Question: Write the caption for this figure.
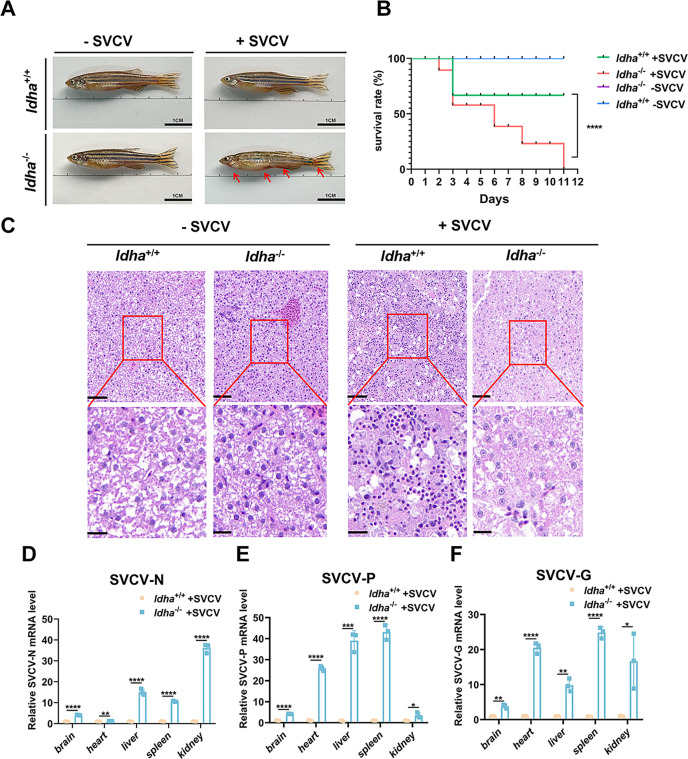
Answer: ldha -null adult zebrafish are susceptible to SVCV infection. ( A ) The ldha −/− zebrafish (3 mpf) displayed enhanced abdominal hemorrhaging compared to the WT controls following the i.p. injection of 10 μL SVCV (~2.5 × 10⁷ TCID₅₀/mL) versus the cell culture medium. The hemorrhagic regions are indicated by red arrows. ( B ) Survival curves for SVCV-infected ldha −/− zebrafish ( n = 20) and their wild-type siblings ( n = 20). ( C ) Hepatic histopathology revealed greater necrosis and cytoplasmic vacuolization in SVCV-infected ldha −/− zebrafish than in their WT siblings. ( D–F ) qRT-PCR analysis of N ( D ), P ( E ), and G ( F ) protein mRNA of SVCV in ldha +/+ and ldha −/− adult zebrafish (3 mpf) 48 hpi. The data presented are the means ± SEM, based on one representative experiment performed in triplicate. * P < 0.05; ** P < 0.01; *** P < 0.001; **** P < 0.0001.